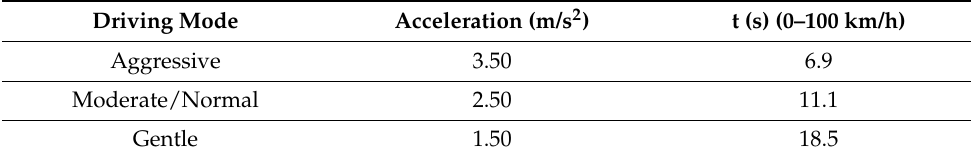
Table 1. Acceleration values for the different driving modes.